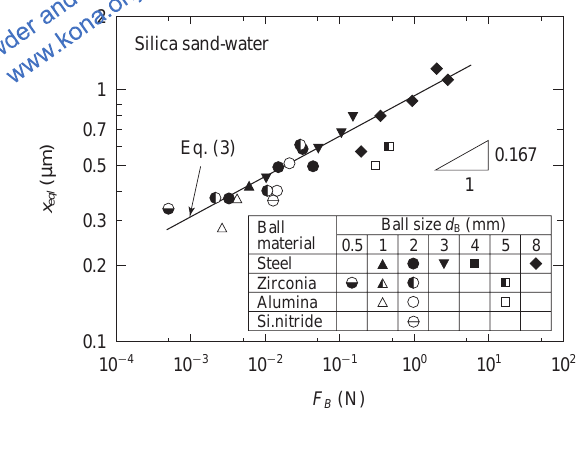
Fig. 2 Correlation between the grinding equilibrium diameter (x eql ) and the maximum force exerting on a single grind- ing ball (F B ) in the planetary ball mill